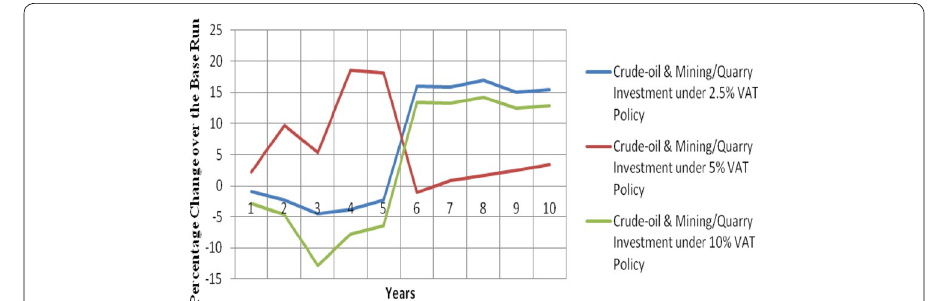
Fig. 23 Changes in crude oil and mining/quarry investment under varying VAT rates